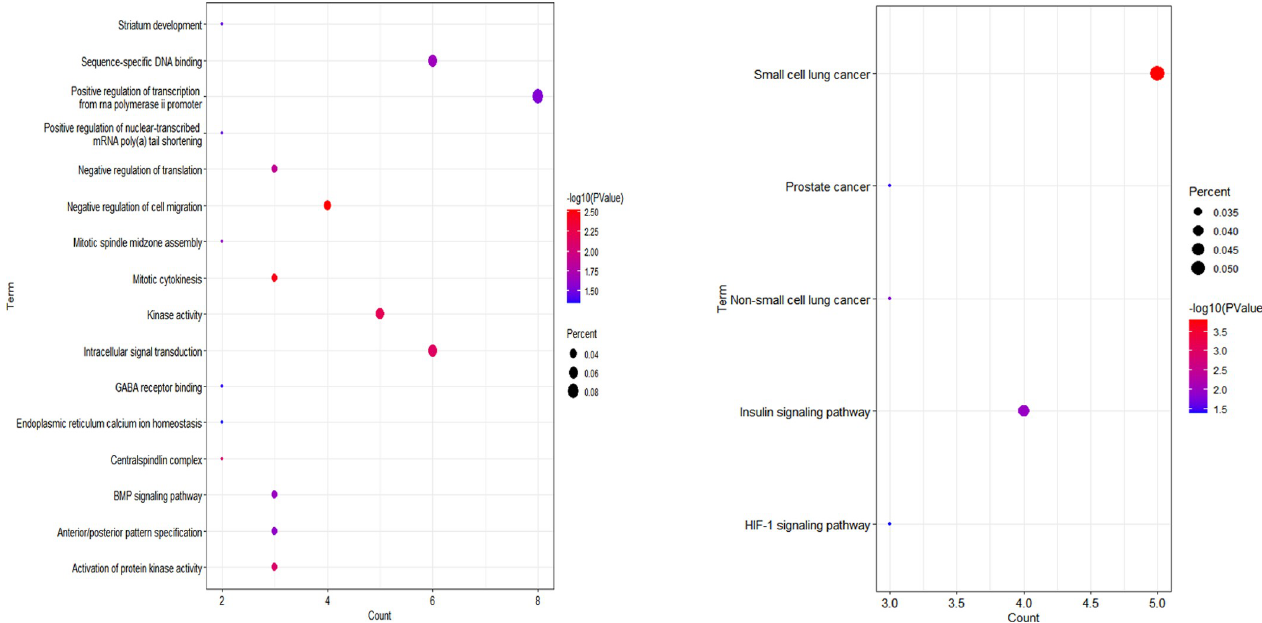
Fig 3. Enrichment analysis of GO (A) and KEGG (B). The x-axis indicates the number of DEmRNAs participating in the given GO term and pathway. GO: Gene Ontology.